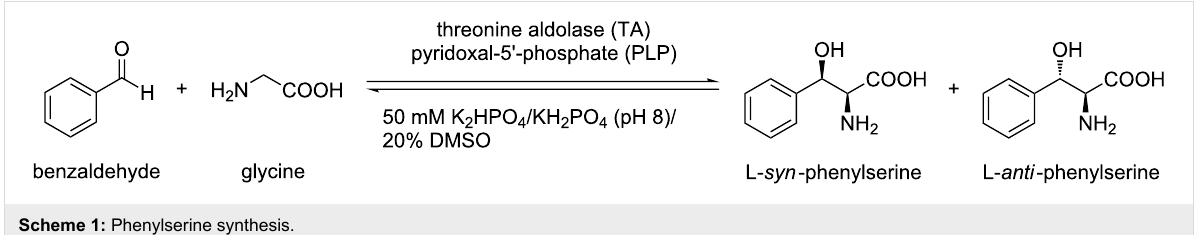
Scheme 1: Phenylserine synthesis.